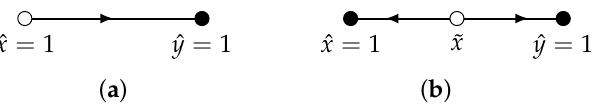
Figure 2. Stability of equilibrium points with different values of d : a black dot represents a stable point, and a white dot represents an unstable point. ( a ) With d < d 1 , the ˆ x = 1 is unstable and ˆ y = 1 r ) / r ( n is asymptotically stable. ( b ) If d 1 < d 1, an unstable equilibrium ˆ x = ( n 1 ) d , denoted − − ≤ by ˜ x , appears, changing the stability of ˆ x = 1, which becomes an stable equilibrium